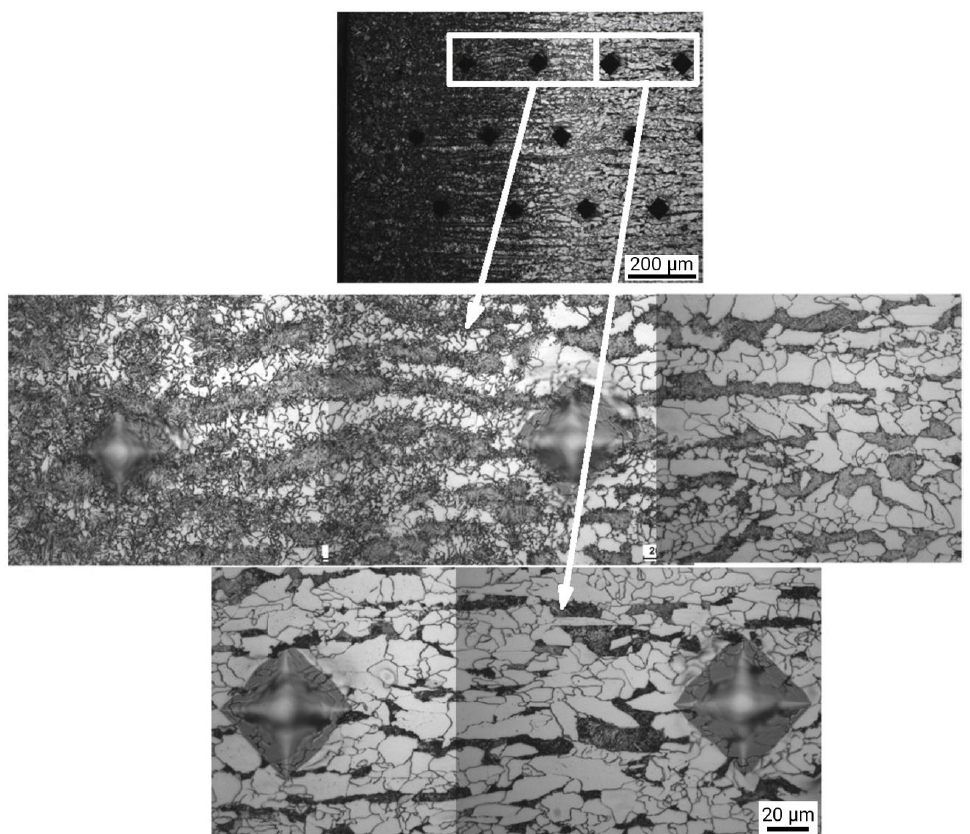
Figure 5. Detail corresponding to the framed area on Figure 4 close to the middle section. The microstructures shown in the second row correspond to the zone closer to the cut edge and its microstructure is finer in regions closer to the cut edge (left).